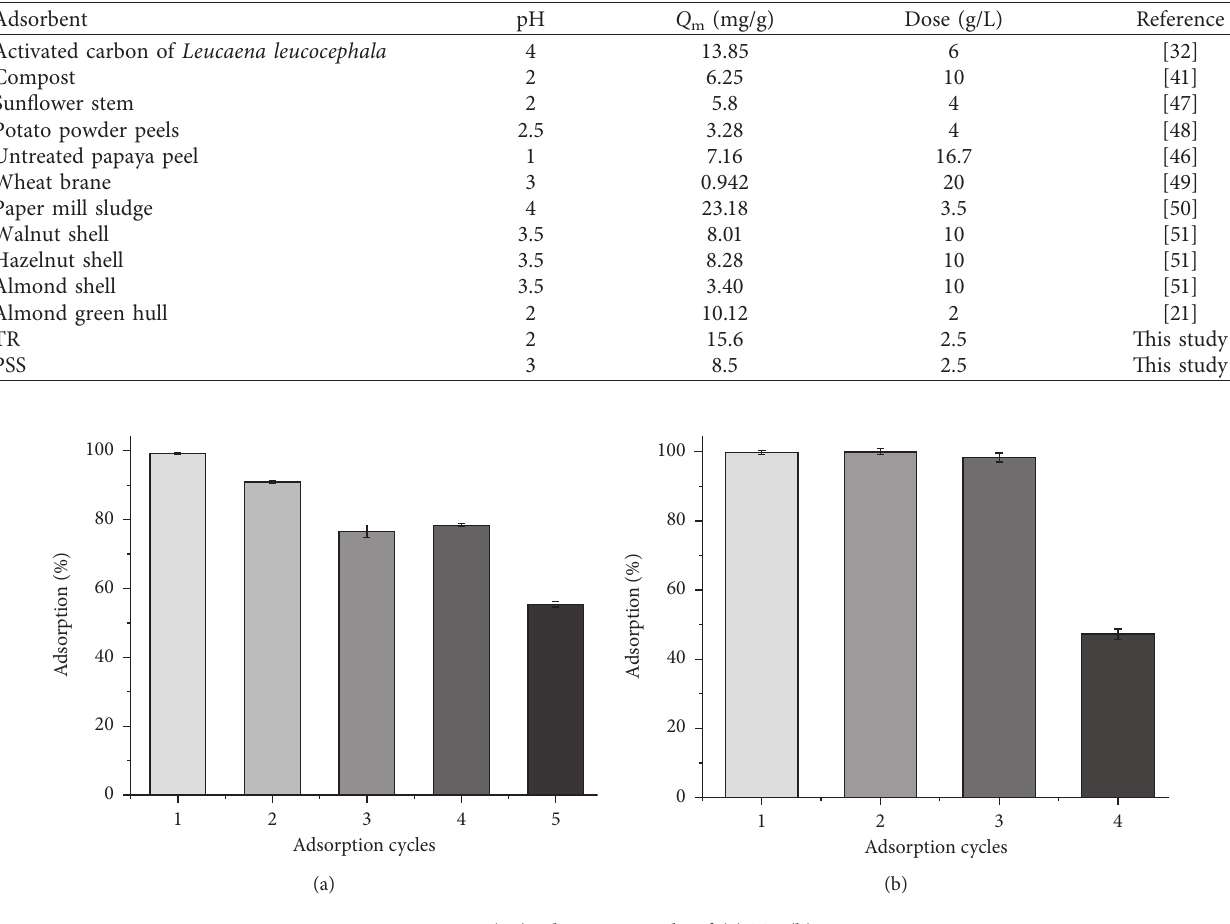
Table 4: Comparison of maximum adsorption capacities of Cr(VI) in various adsorbents with and without activation. Adsorbent pH Q m (mg/g) Dose (g/L)